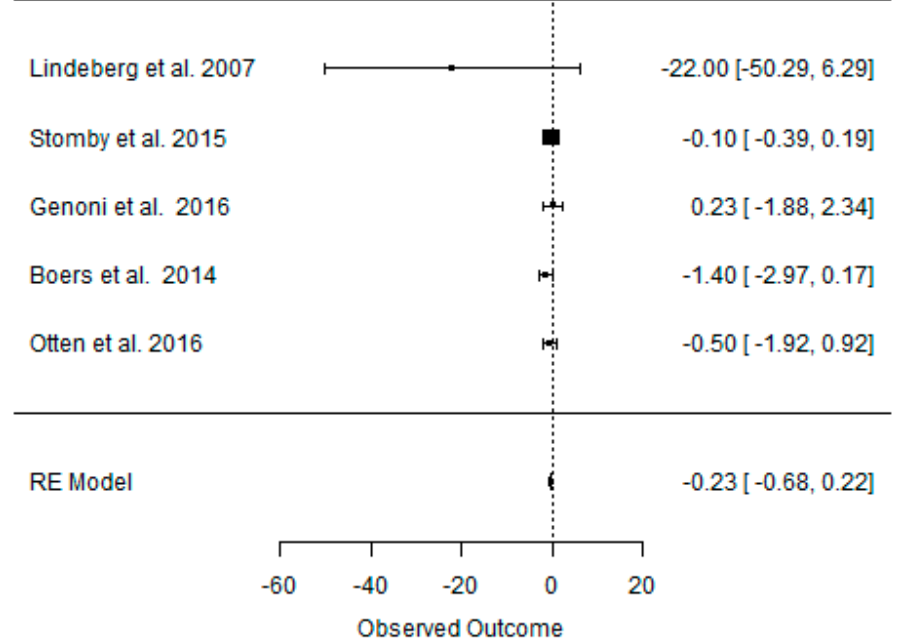
Figure A49. Forest plot of the effect of a CD on fP insulin (mmol/L) in the short term (weighted mean difference).